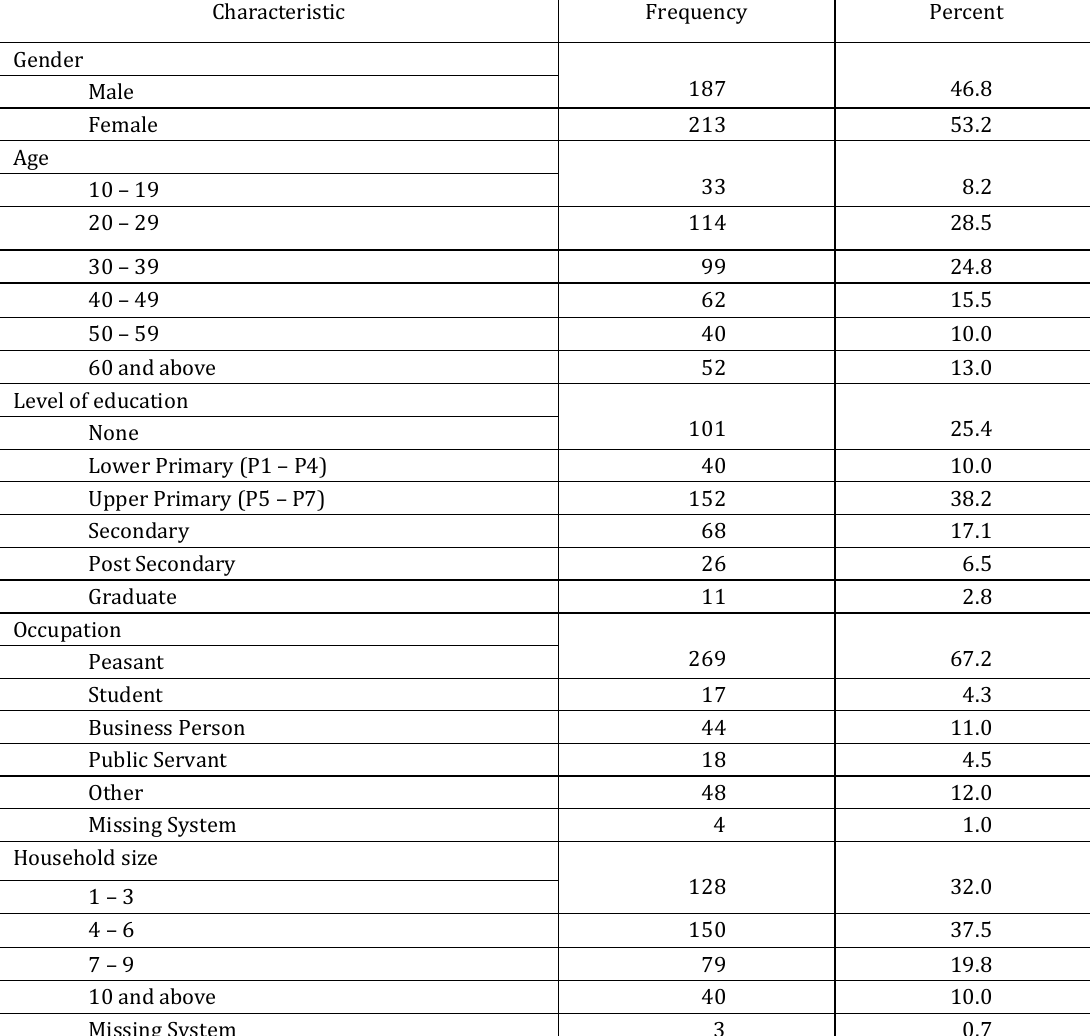
Table 1. Household characteristics of respondents, Author’s questionnaire